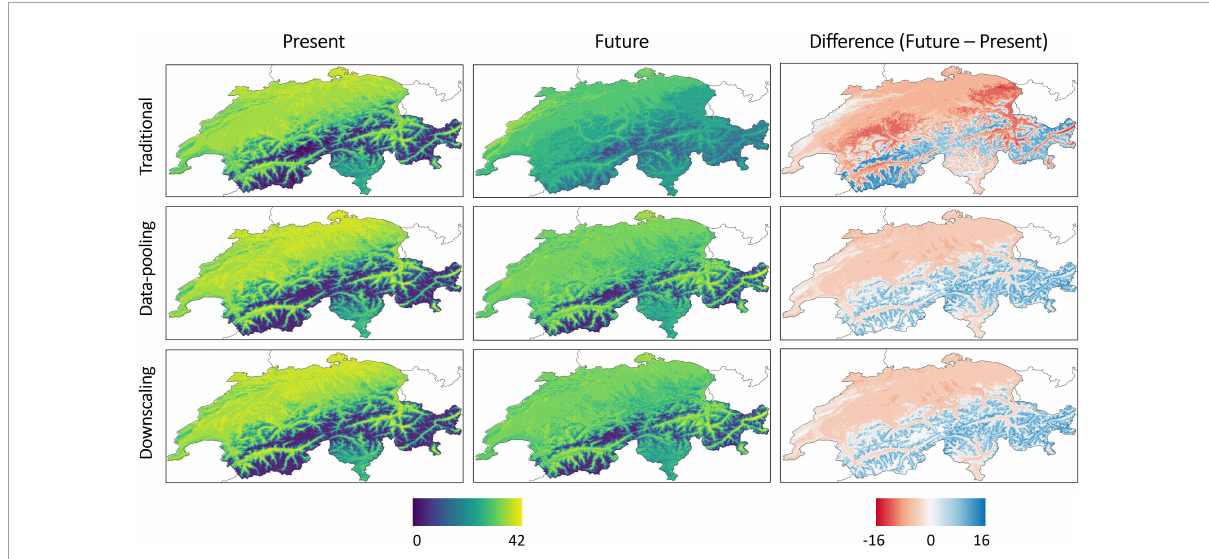
FIGURE4 Spatial representation of species richness predicted under current and future environmental conditions for all 1-km pixels over Switzerland along with the difference between them for the three considered models. Species richness was computed by summing the predicted suitability values for all bird